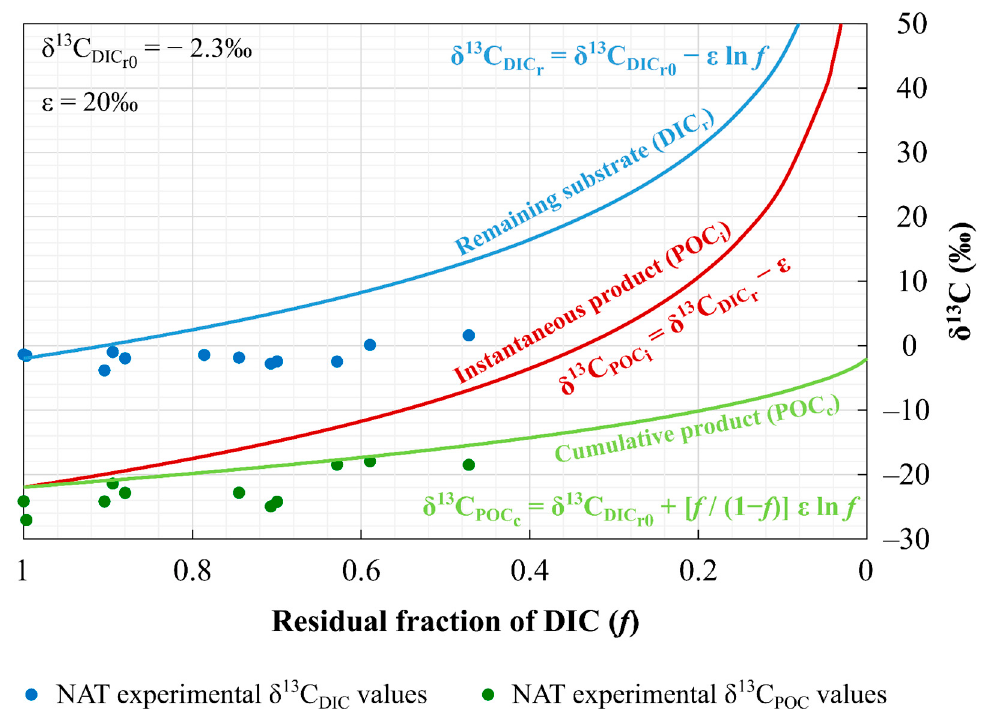
Figure 8. Closed-system Rayleigh-type fractionation relationship calculated for the three T. rotula culture experiments in the natural seawater medium (NAT). The isotopic composition of the residual fraction ( f ; 0 ≤ f ≤ 1) of unutilised substrate remaining (DIC r ) is represented by the blue line ( δ 13 C DICr ), and the isotopic composition of the cumulative (POC C ) and instantaneous (POC i ) products are shown by the green ( δ 13 C POCc ) and red ( δ 13 C POCi ) lines, respectively. The experimental data of the δ 13 C POC and δ 13 C DIC from the three NAT experiments are also plotted as green circles and blue circles, respectively. The mathematical formulae for reactants and products are shown [110].